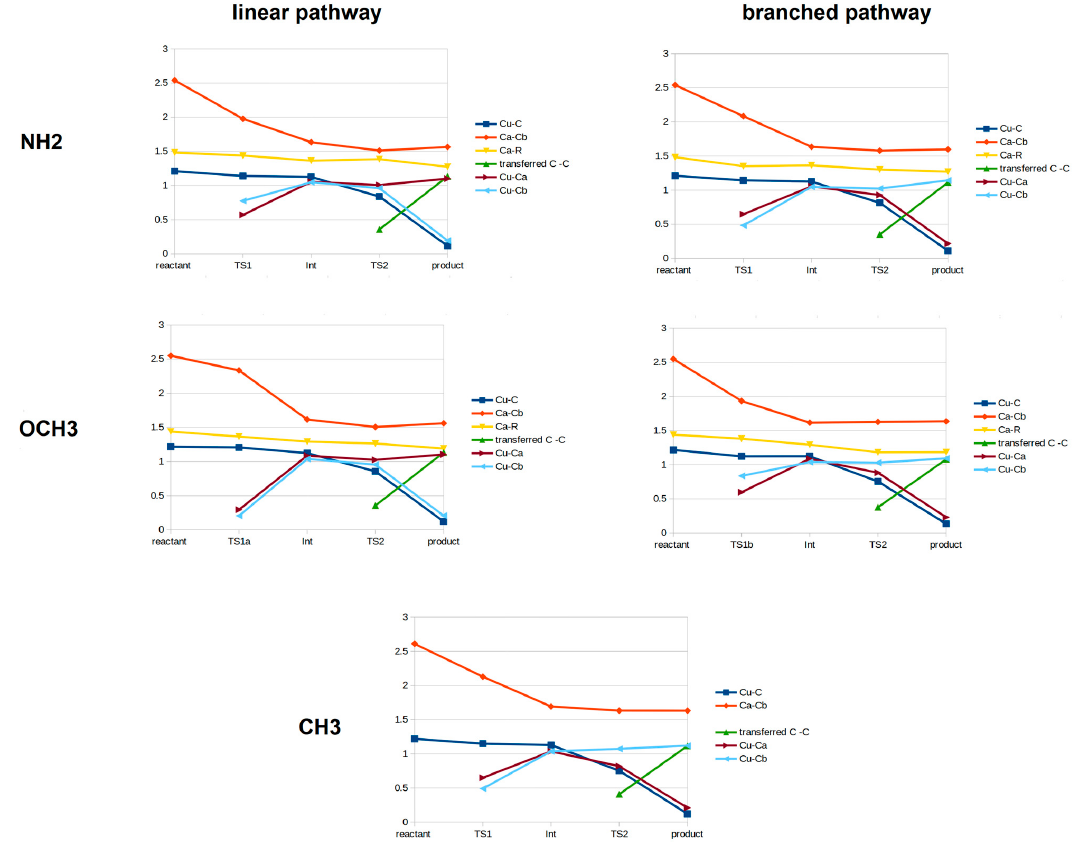
Table 2. Relative free energies (kcal·mol − 1 ) of infinitely-separated reactants, π -complexes, transition states and products of the addition of [Cu(CH3)2] - to alkynes of the form R-C ≡ C-CH 3 . For each alkyne, all energies are shown relative to the energy of its most stable π -complex. Single-point energies were computed at the PBEPW91/6-311G(2d,p)//6-31G(d), including solvation effects in THF and zero-point and vibrational effects at 223 K. Branched Pathway Linear Pathway